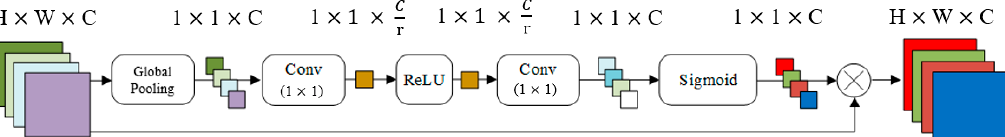
Figure 3. Sub-pixel convolution module.